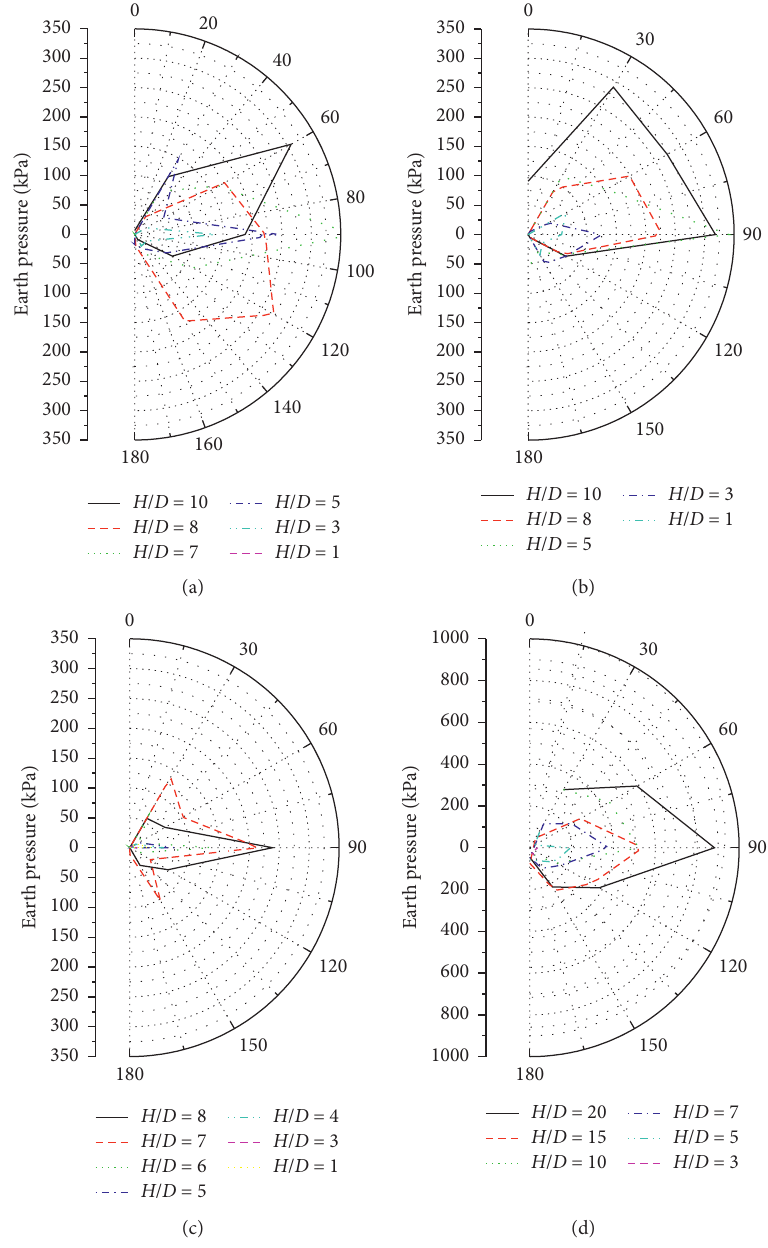
Figure 12: Distribution of Earth pressure on upstream surface of the pipe. (a) Case 1, (b) Case 2, (c) Case 3, and (d) Case